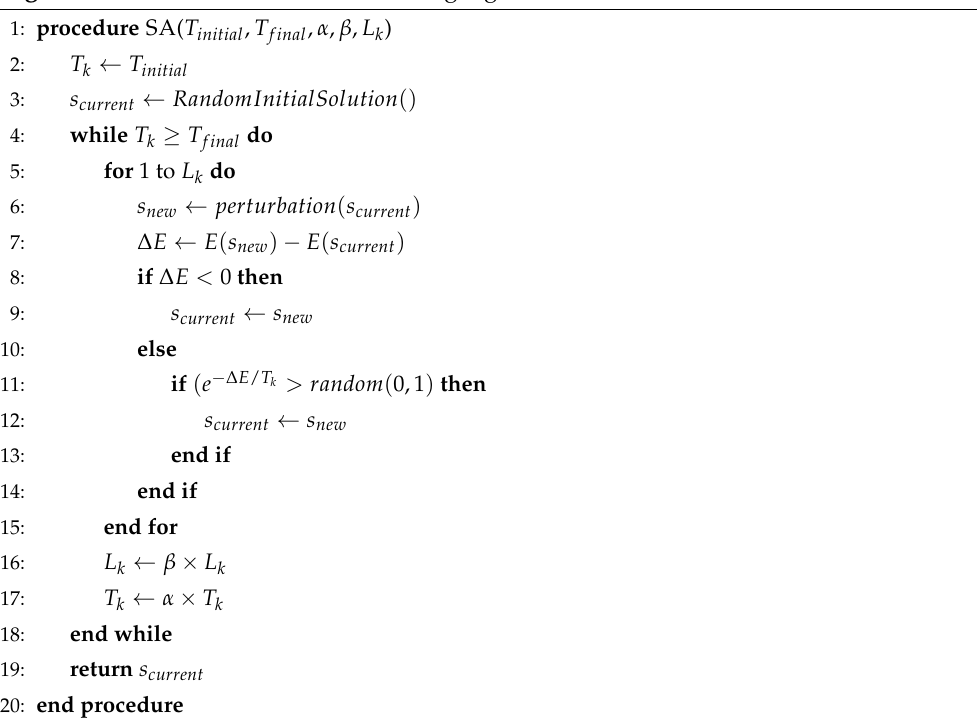
Algorithm 1 Classic Simulated Annealing